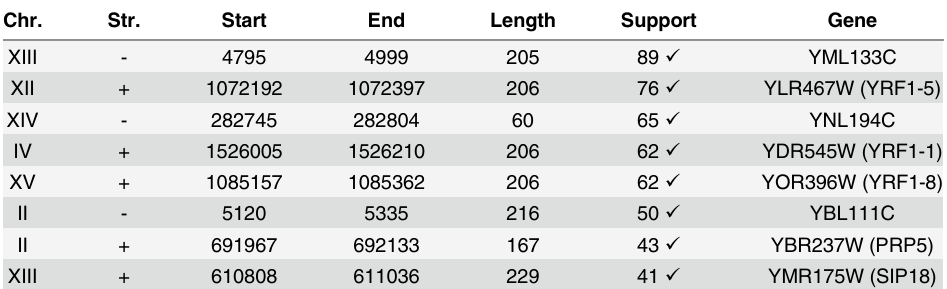
Table 3. Novel introns in the 5 ’ UTR.